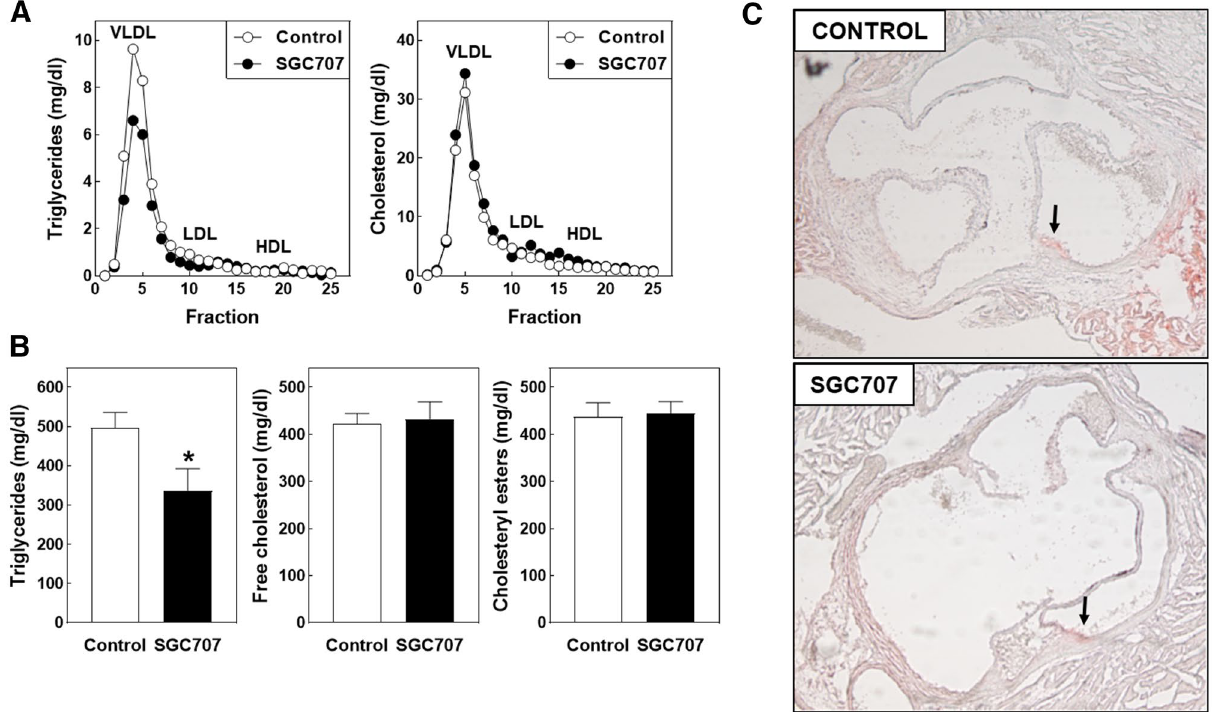
Figure 2. ( A ) The distribution of cholesterol and triglycerides over very-low-density lipoprotein (VLDL), low-density lipoprotein (LDL), and high-density lipoprotein (HDL) fractions and ( B ) plasma total lipid levels in Western-type diet-fed male LDL receptor knockout mice treated with the PRMT3 inhibitor SGC707 or the solvent control. Values in the graphs represent the means + SEM of 11 mice per group. * P < 0.05 versus control. ( C ) Representative images of Oil red O-stained aortic root sections with arrows indicating the minimal vascular lipid deposition (magnification: